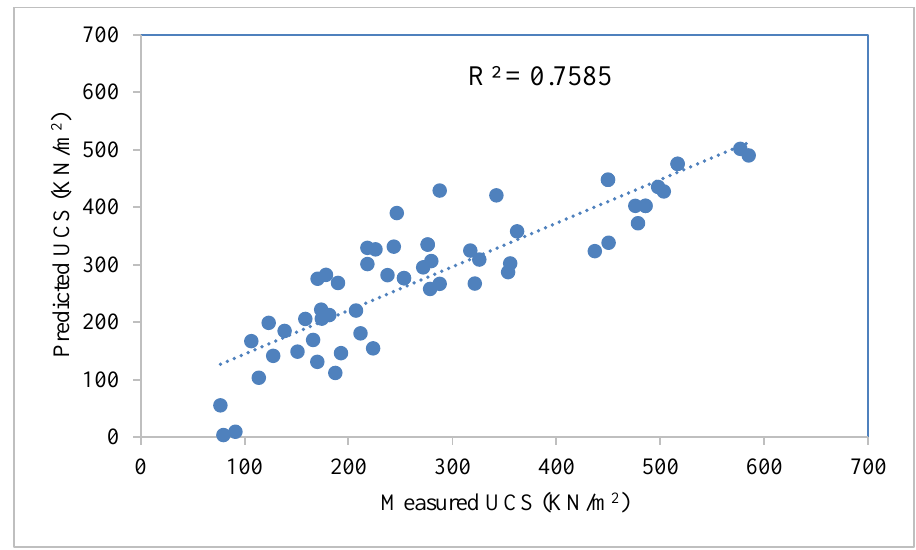
Fig. 2. Measured and predicted UCS from the regression model.